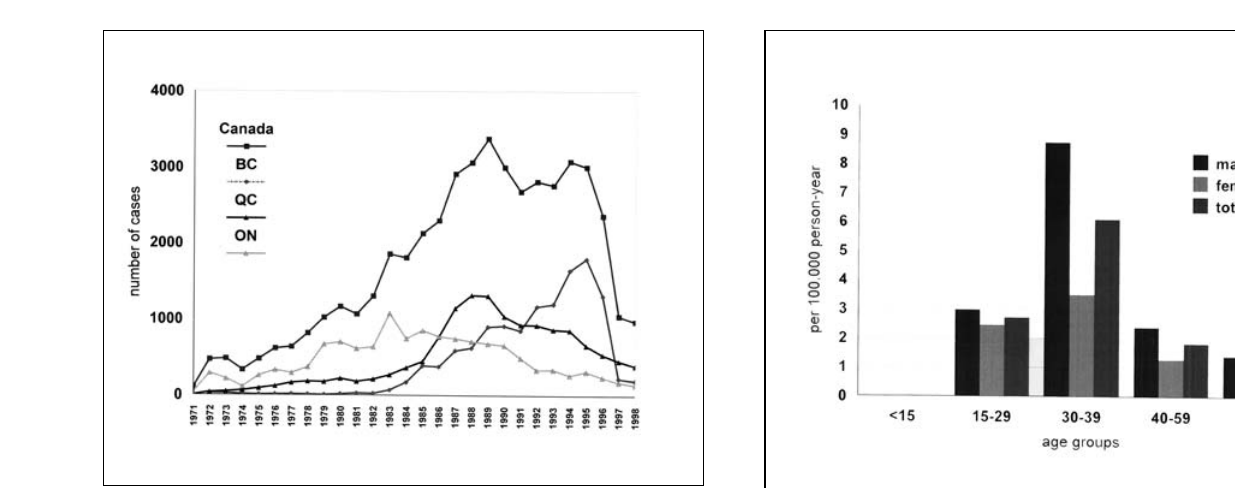
Figure 1) Reported hepatitis cases in Canada from the National Notifiable Disease Reporting system from 1971 to 1998. BC British Columbia; ON Ontario; QC Quebec